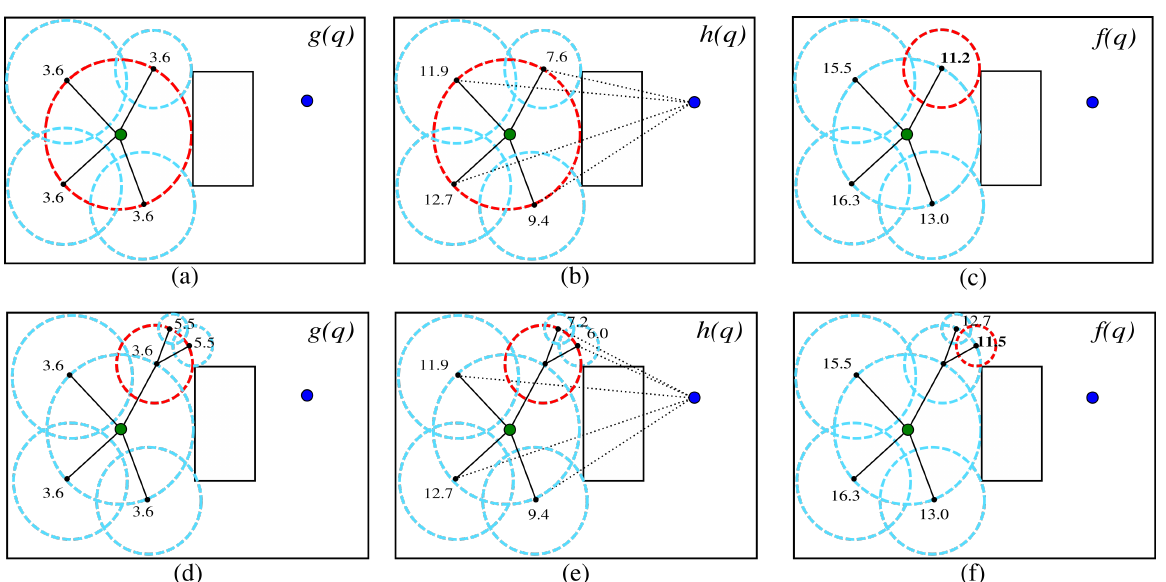
Figure 7. HPF propagation starting from q init (green dot). ( a ) Computation of g cost for all children bubbles on the parent bubble (red circle). ( b ) Computation of h cost based on goal configuration (blue dot). ( c ) Computation of f cost, and selection of the new parent bubble. ( d ) Cost g for the new generation. ( e ) Cost h for the new generation. ( f ) Cost f for new generation, and selection of the new parent